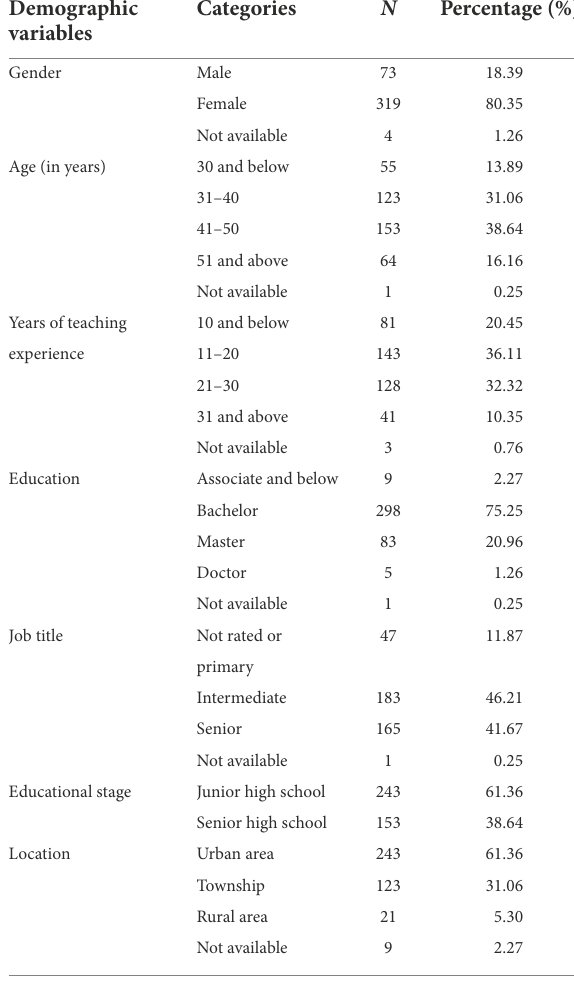
TABLE 2 Basic information of teachers surveyed. Demographic